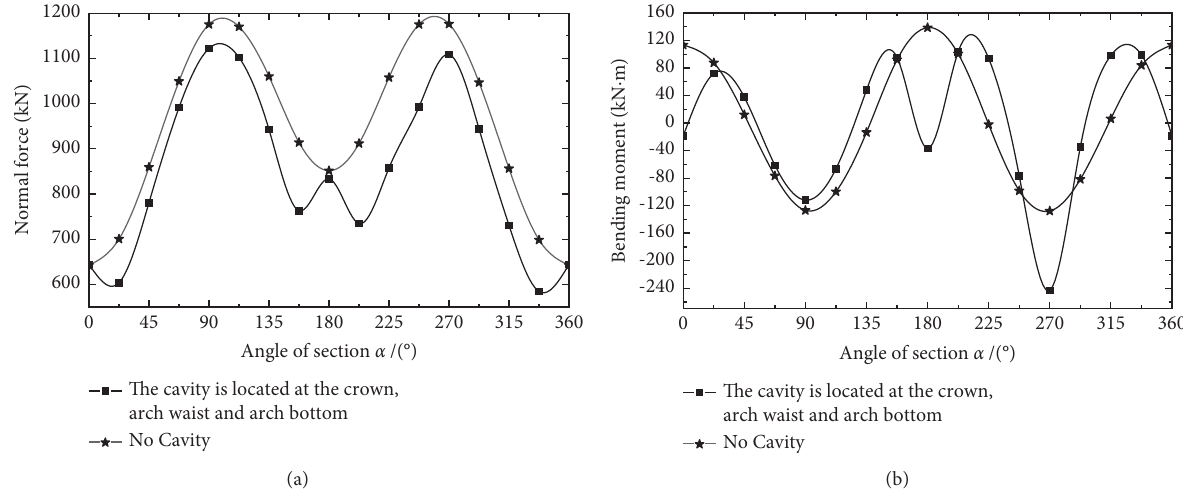
Figure 31: Internal force diagram of the vault top, arch waist, and cavity behind the arch bottom. (a) Segment axial force. (b) Segment bending moment.